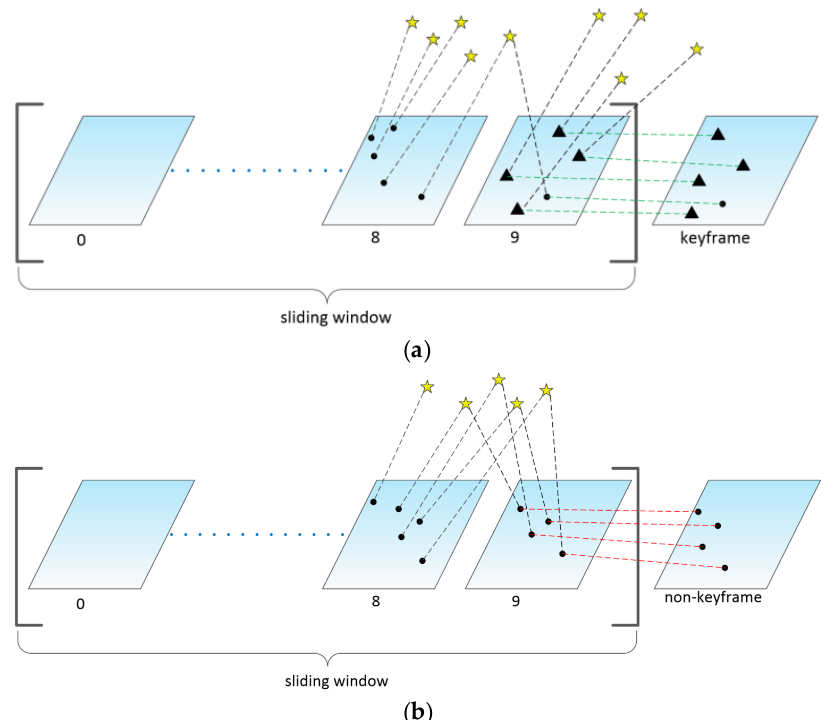
Figure 3. The top chart ( a ) shows how to track a keyframe. The black triangle represents the newly extracted feature points on the 10th frame (last frame) of the sliding window, while the green dotted line represents tracking them in the keyframe by KLT sparse optical flow algorithm. The bottom chart ( b ) shows how to track a non-keyframe. The red dotted line indicates that the feature points on the 10th frame of the sliding window are tracked on the non-keyframe by the direct method.